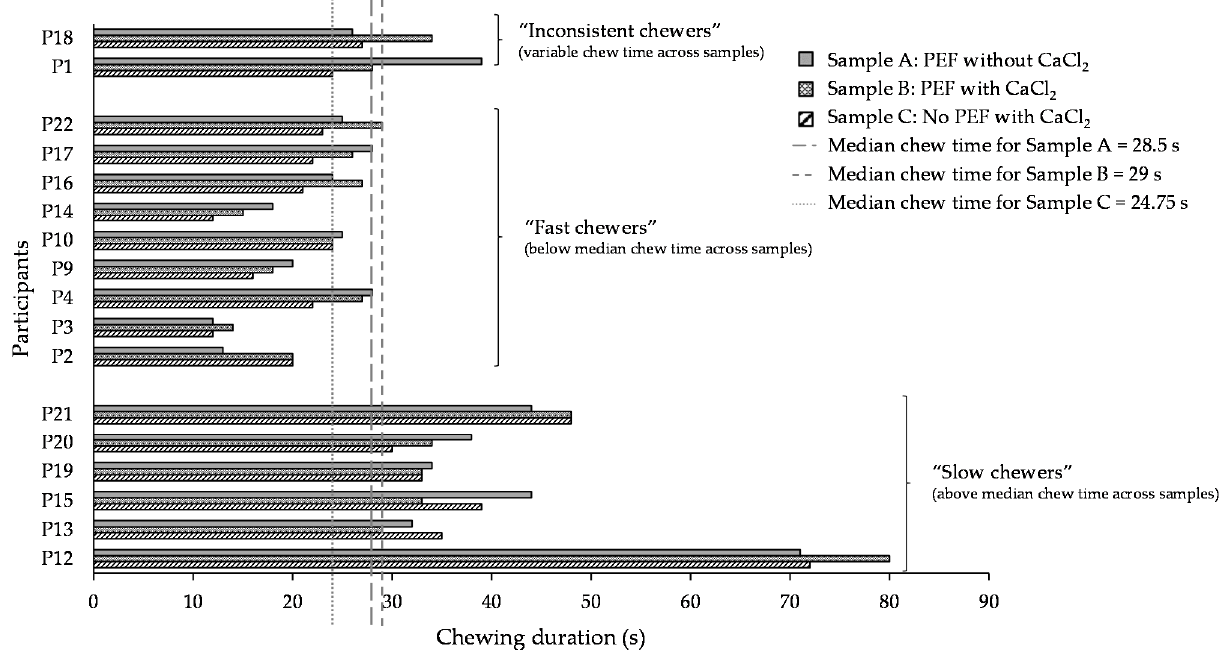
Figure 3. Variations in the chewing duration of participants ( n = 17) for three different sample types (A: PEF and thermally processed without CaCl 2 addition; B: PEF and thermally processed with CaCl 2 addition; and C: No PEF, thermally processed with CaCl 2 ). Long, short, and dotted lines correspond to the median chewing duration for each sample type. Participants with variable chewing duration across three samples are defined as “inconsistent chewers”, participants with chewing duration below the median line for all three samples are defined as “fast chewers”, and participant with chewing duration above the median line for all three samples are defined as “fast chewers”.